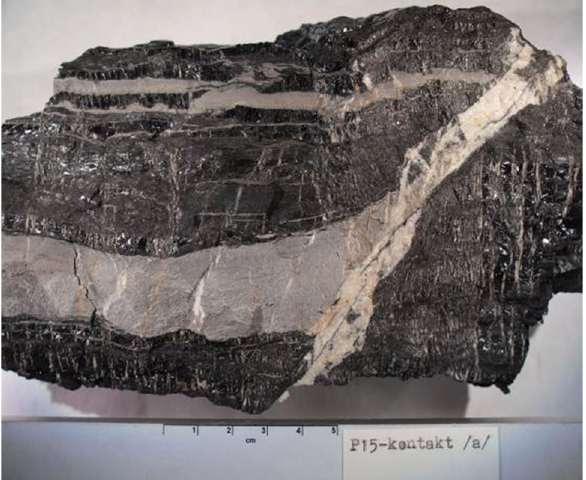
Fig. 7 Banded coal with a horizontal grey tuffitic layer and a diagonal calcite